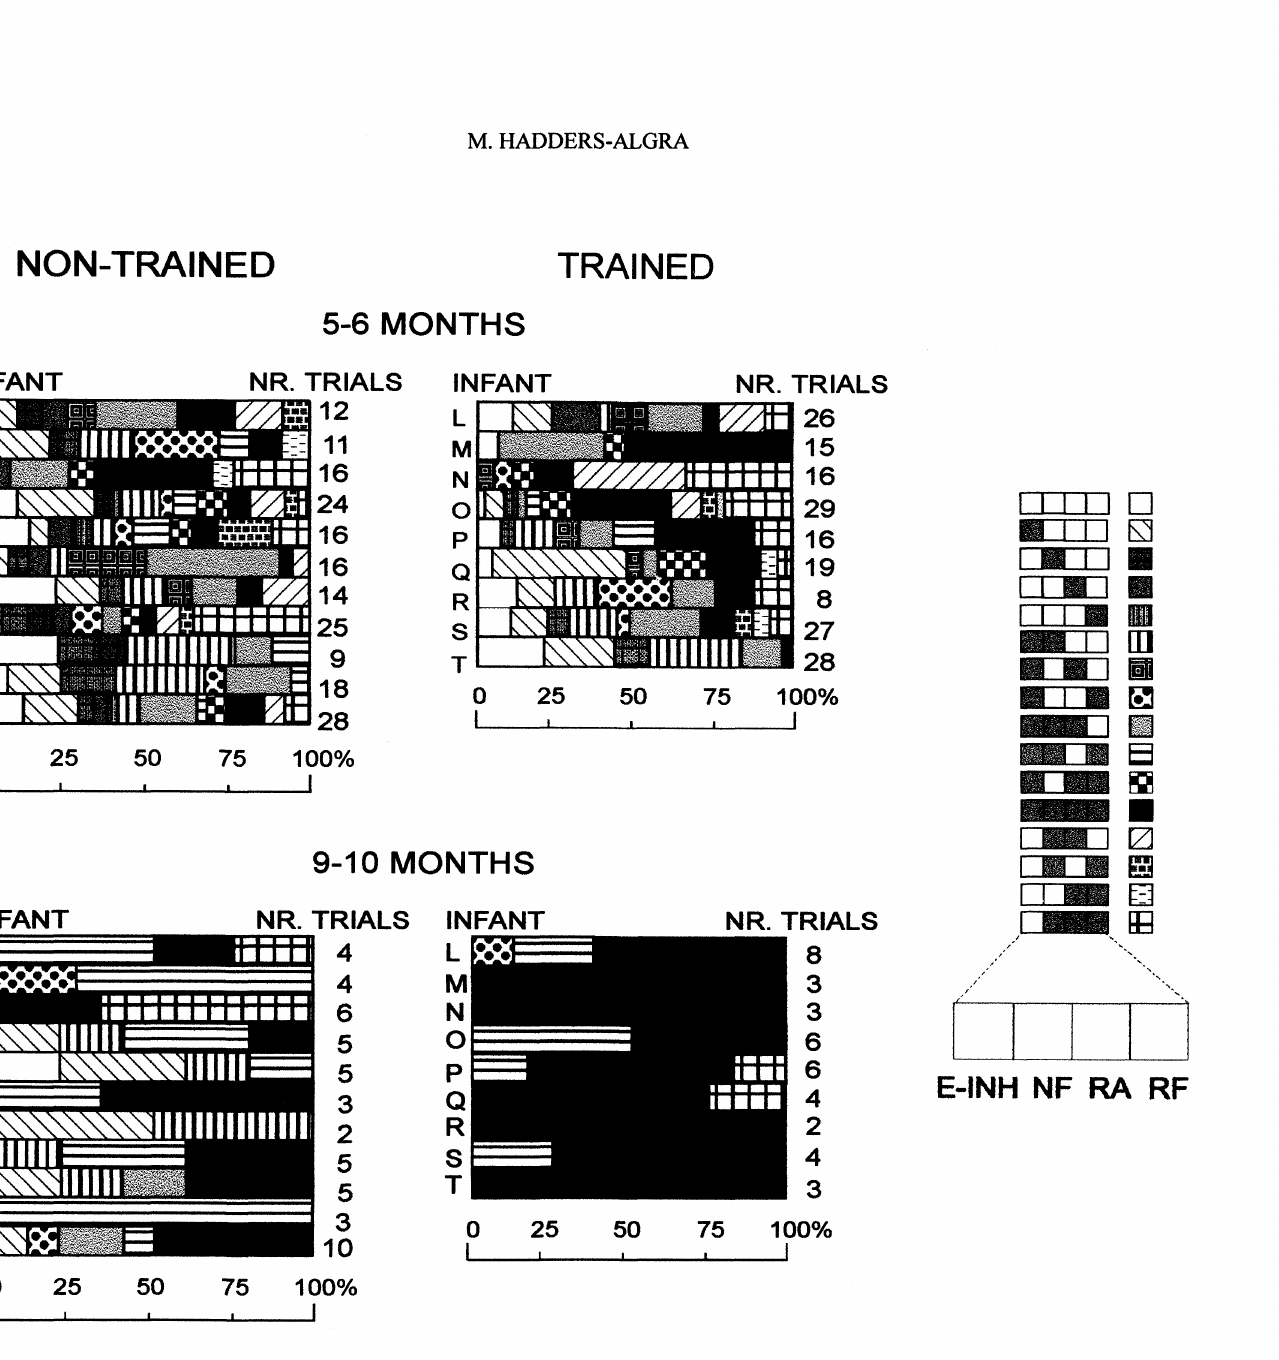
Fig. 2: Developmental changes in postural adjustments during sitting in 20 healthy infants. The balancing abilities in nine infants was trained by their parents by presenting the infants attractive toys, sidewards, and semi-backwards in the borderzone of reaching without falling (’trained’ group). Training was performed three times a day for five minutes for a period of three months after the first assessment of the postural adjustments. The postural adjustments were assessed at the ages of 5-6 and 9-10 months during slow translations of a moving platform which induced a backward sway of the body of the sitting infant. In each horizontal bar, the distribution of response patterns of the direction specific postural adjustments for one subject is represented. The diagram on the right supplies the hatching codes of the response patterns used in the left part of the figure. In this diagram the shading of the squares indicate: square number 1" inhibition of one or more extensor muscles, square number 2: activation of NF neck flexor muscle, square number 3" activation of RA rectus abdominis muscle, square number 4: activation of RF rectus femoris muscle. NF, RA and RF are the direction specific muscles activated to prevent a fall of the body in backward direction. Note the decrease in variation of response patterns with increasing age, a process which is significantly enhanced by daily balance training, and which results in selection of the pattern in which all direction specific muscles are activated. Adapted from Hadders-Algra et al.